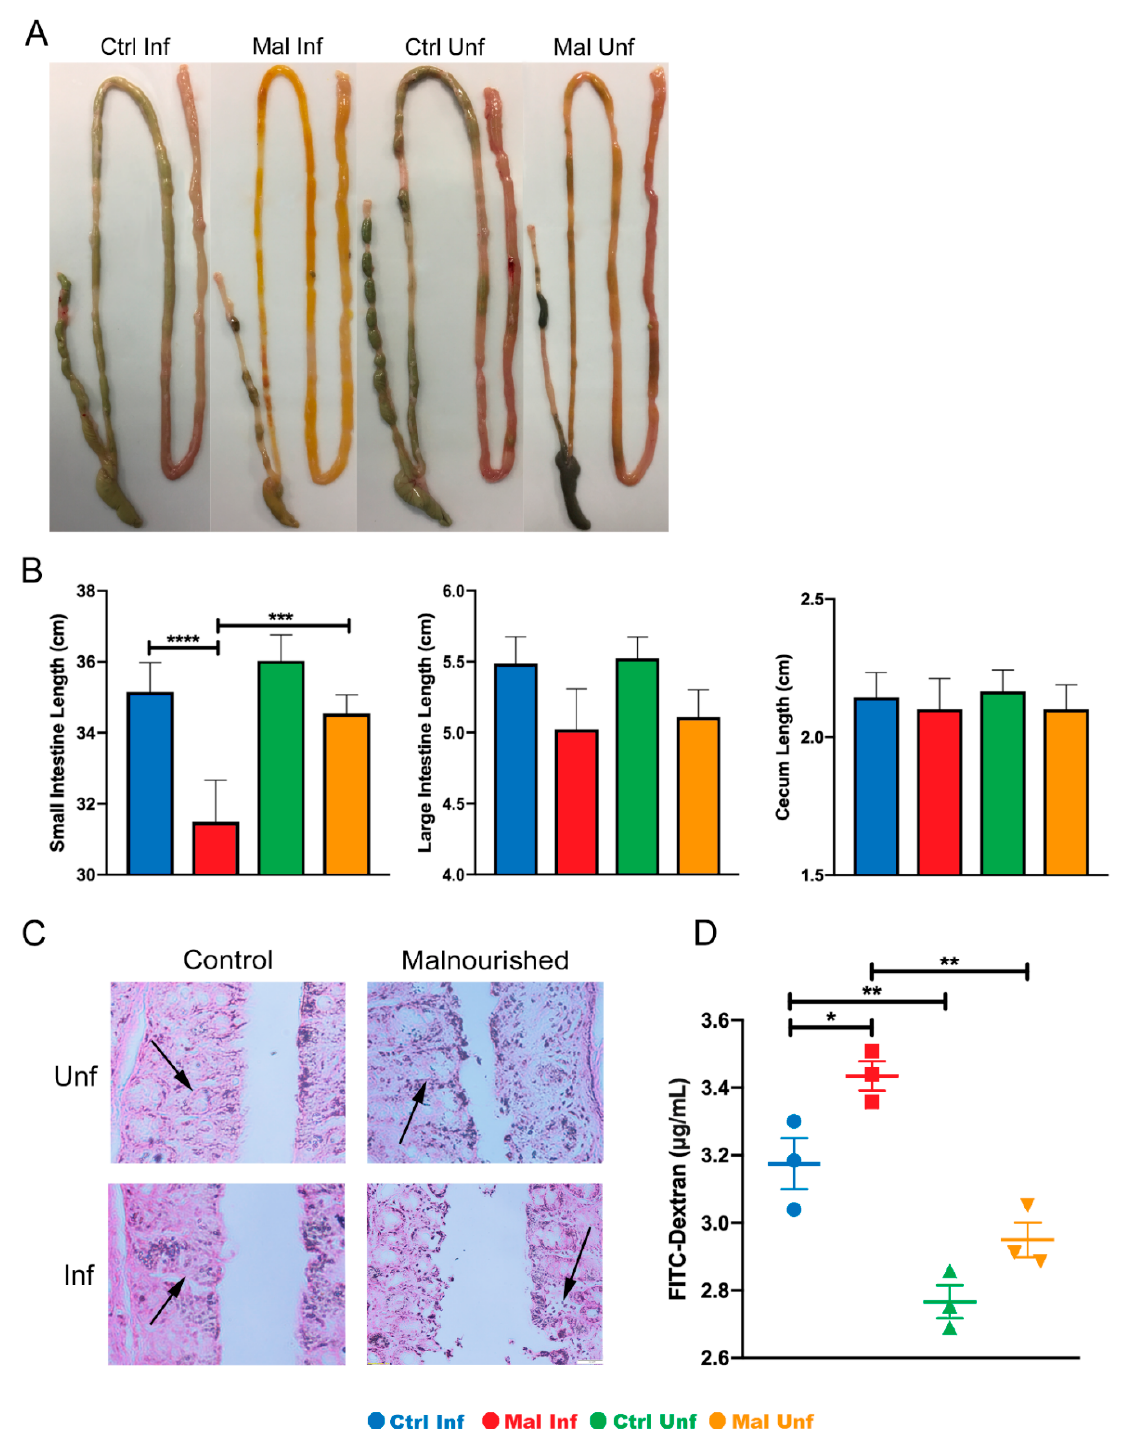
Figure 2. Moderate malnutrition alters gut phenotype, morphology and length after infection with P. chabaudi . ( A ) Macroscopic images of entire gut tissue. ( B ) Lengths of small intestines, large intestines, and cecum (average lengths from 16 independent experiments, n = 48). ( C ) Histology sections of the small intestine showing damaged mucosal cells indicated by arrows. ( D ) Serum FITC-Dextran concentrations. Data are shown as means ± SE. Histology and FITC-Dextran concentrations are representative of one experiment ( n = 3). Statistical analysis was performed using a two-way ANOVA followed by the Tukey’s test. * p < 0.05; ** p <0.01; *** p < 0.001; **** p < 0.0001, indicates a statistically significant difference between treatments.